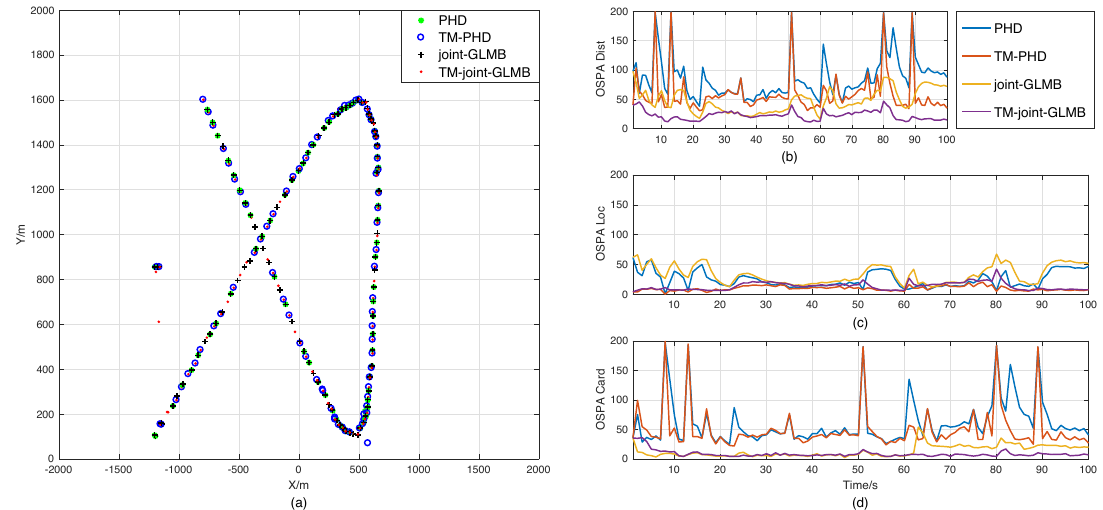
Figure 5. Result comparisons in Scenario 2. ( a ) Position estimations of the original RFS-based filters and the time-matching filters in one trial. ( b ) OSPA errors. ( c ) Location components of OSPA. ( d ) Cardinality components of